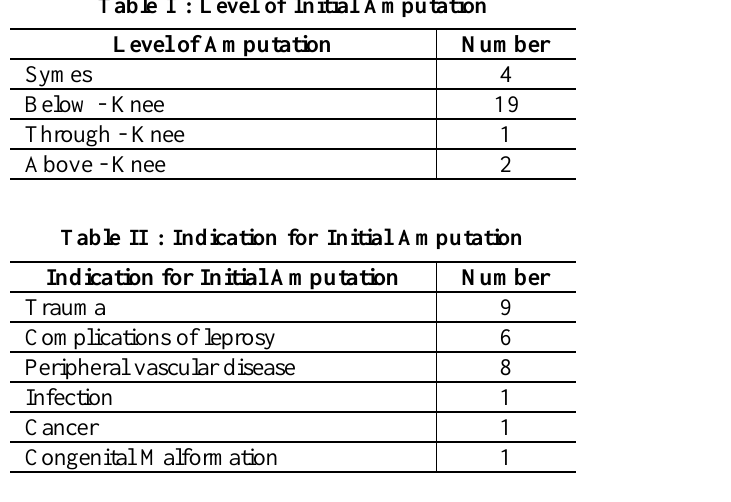
Table III : Indication for Indication for Revision